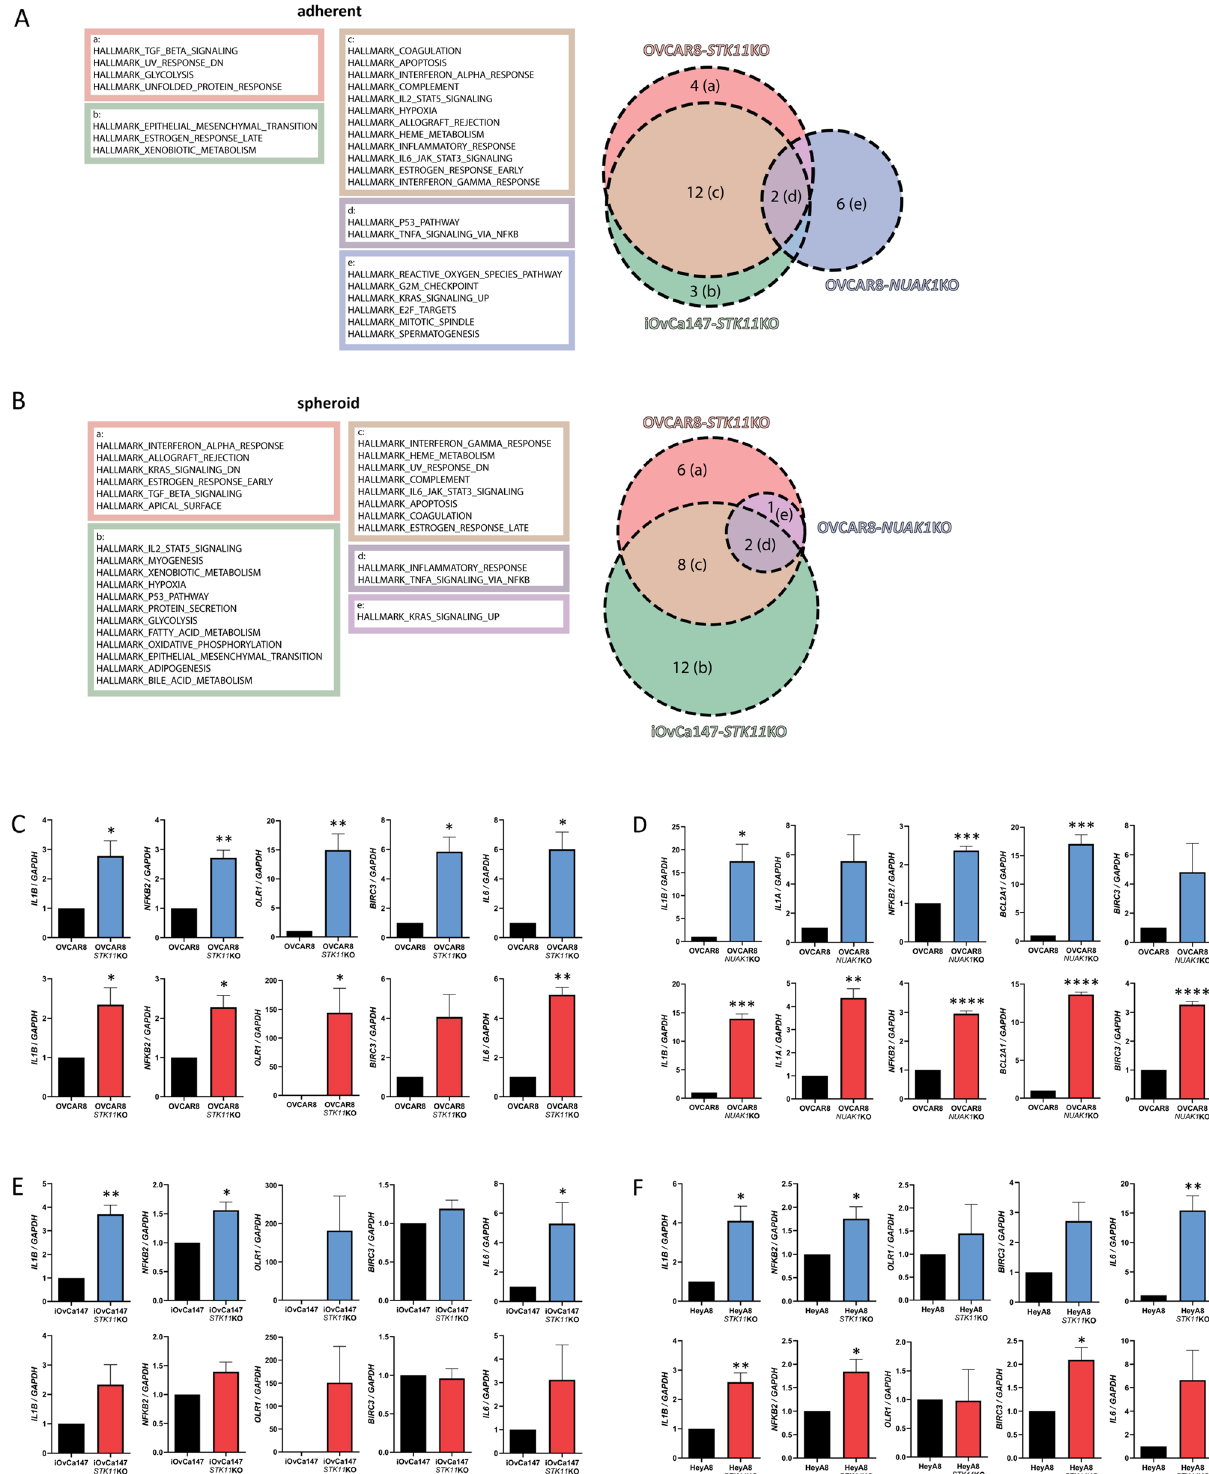
Figure 1. Enrichment of inflammation-associated transcriptional signatures in EOC cell lines lacking LKB1 or NUAK1. ( A , B ) Transcriptional signatures enriched in STK11 KO or NUAK1 KO cells as compared with parental EOC cells in adherent culture ( A ) or spheroid culture ( B ). Lists of Hallmarks were determined using Gene Set Enrichment Analysis (BROAD Institute; p-value cutoff: 0.05, FDR cutoff: 0.25). ( C – F ) Expression of selected NF-κB-target genes by RT-qPCR in OVCAR8- STK11 KO ( C ), OVCAR8- NUAK1 KO ( D ), iOvCa147- STK11 KO ( E ), and HeyA8- STK11 KO ( F ) cell lines. Data from adherent culture of knockout cell lines shown in blue and spheroid culture of knockout cell lines are shown in red. Knockout cells were compared with parental cell controls by unpaired, two-tailed Student’s t -test (*p ≤ 0.05, **p ≤ 0.01, ***p ≤ 0.001, ****p ≤ 0.0001; n = 3). Error bars indicate standard error of the mean